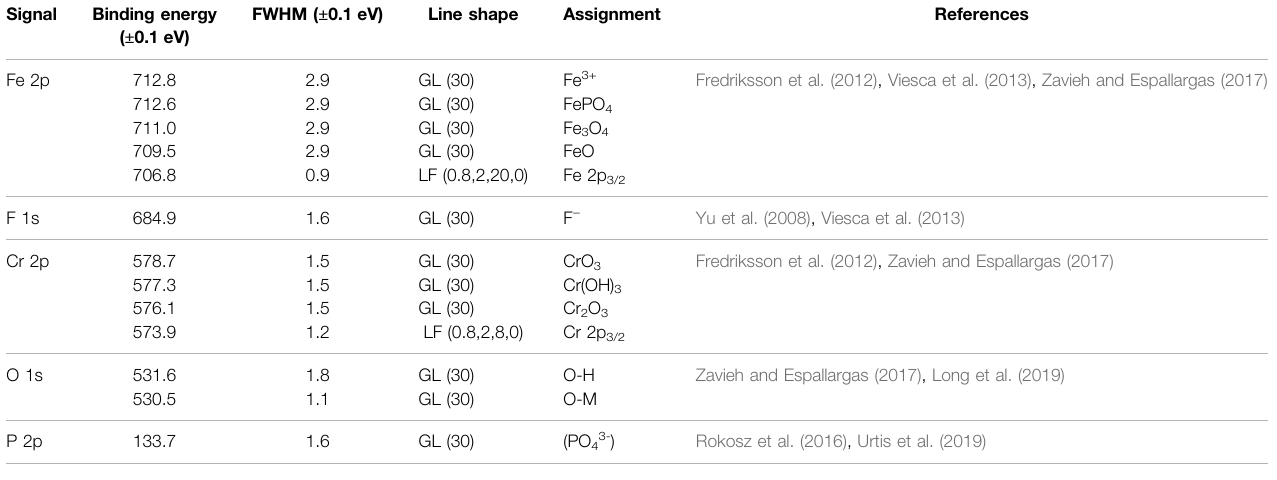
TABLE 2 | Detailed curve- fi tting parameters of compounds used for XPS characterization. Signal Binding energy ( ± 0.1 eV)